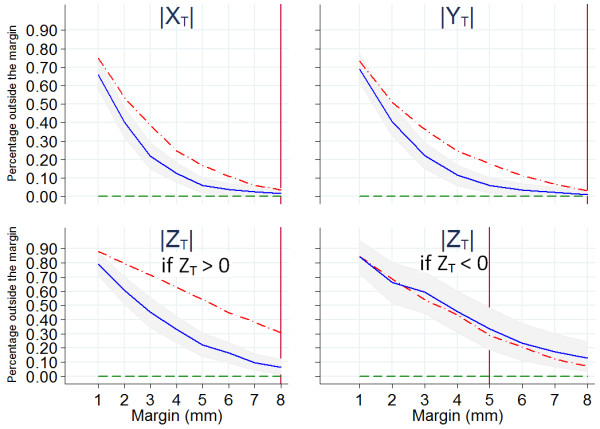
Percentage of the total fractions outside the margins, for margins from 1 to 8 mm. The data (all the fractions, all the patients) are computed by using the absolute values of the shifts given by the T-match. Dotted-dashed lines show the results if no correction is made on patient position. Solid lines show the results of a simulated off-line protocol based on the first 5 CBCTs. The area in grey represent the 5% and 95% confidence levels. Dashed lines show the results if a daily correction is made on the basis of daily CBCT. For the antero-posterior (Z) axis the percentages are divided into two cases, Z positive and Z negative, because there is no symmetry in the margins we apply for the positive and negative directions. The vertical lines are positioned at the margins currently used.